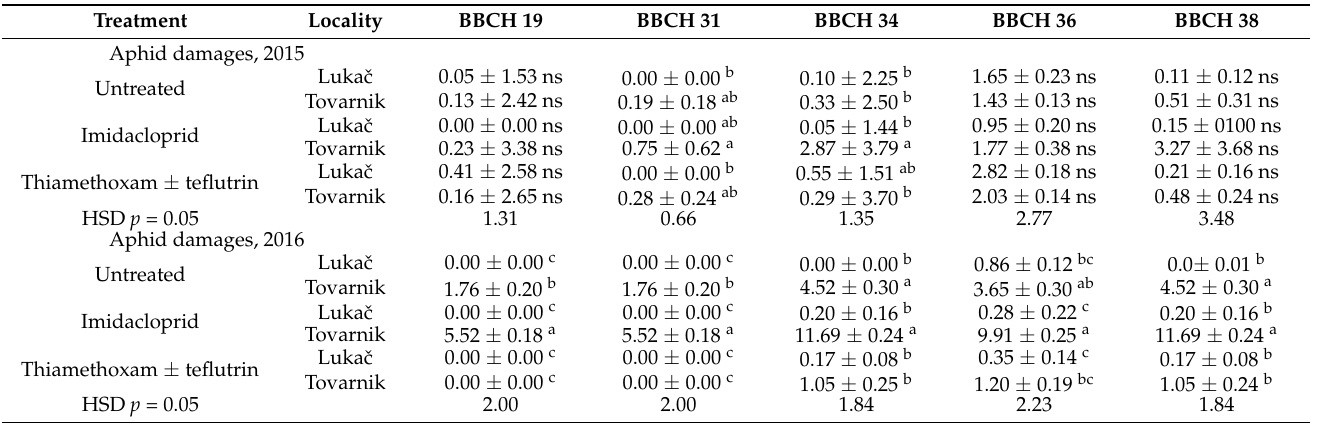
Table 9. Aphid damages on sugar beet plants in different developmental